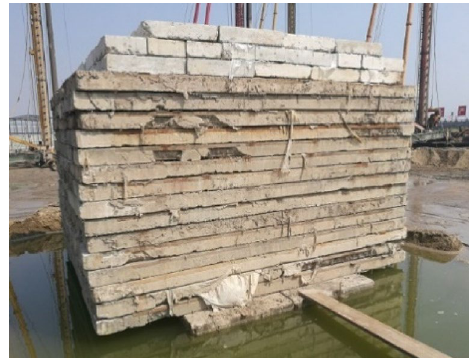
Figure 8. On-site preloading.